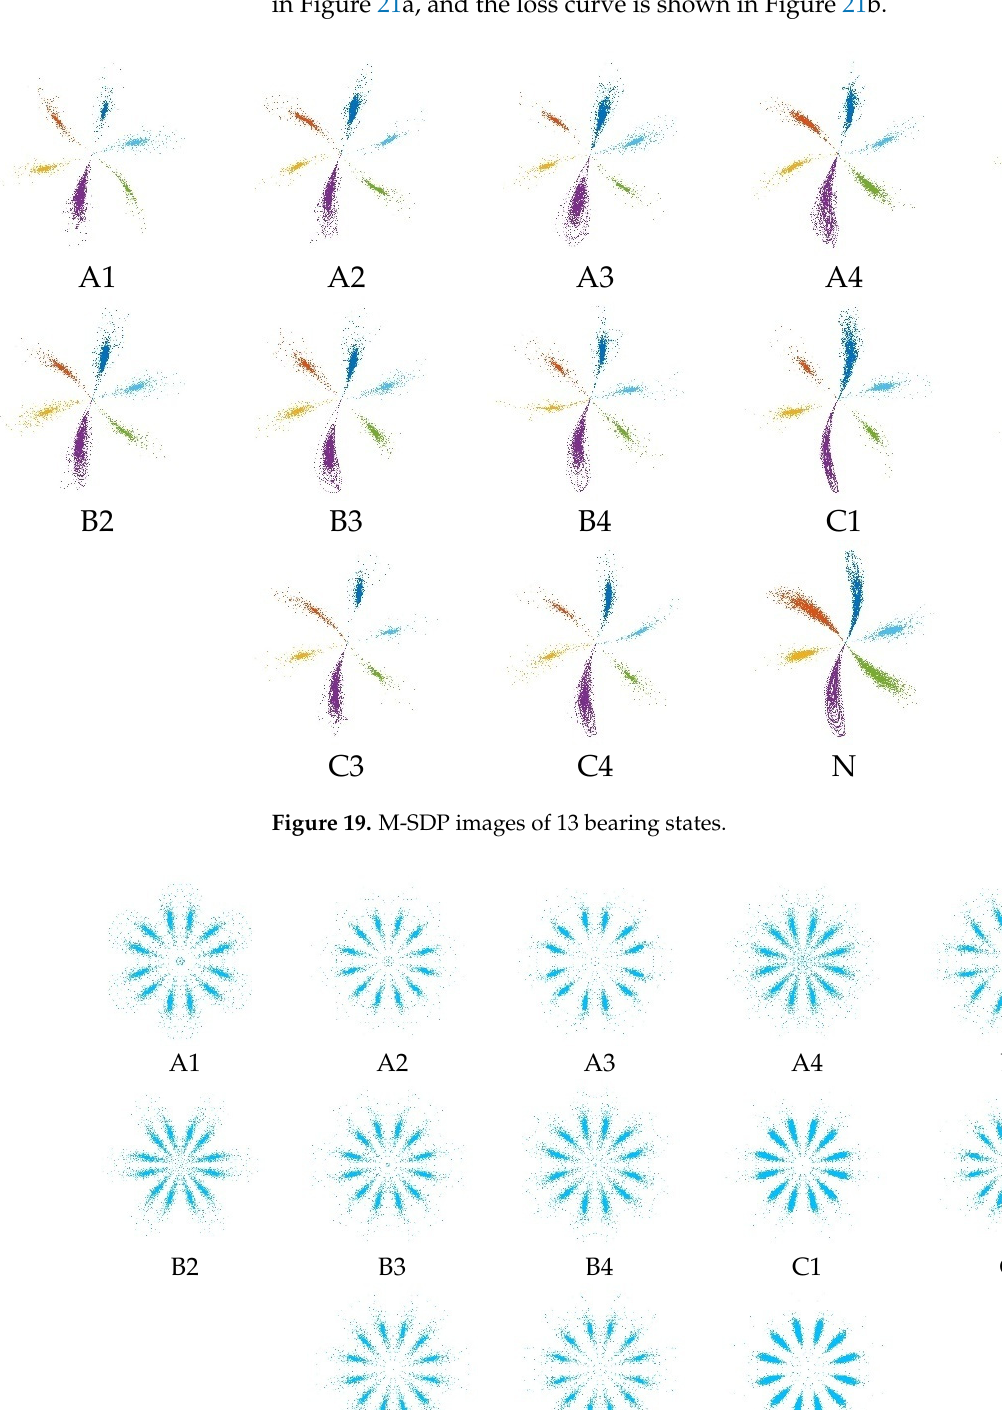
Figure 20. SDP images of 13 bearing states.